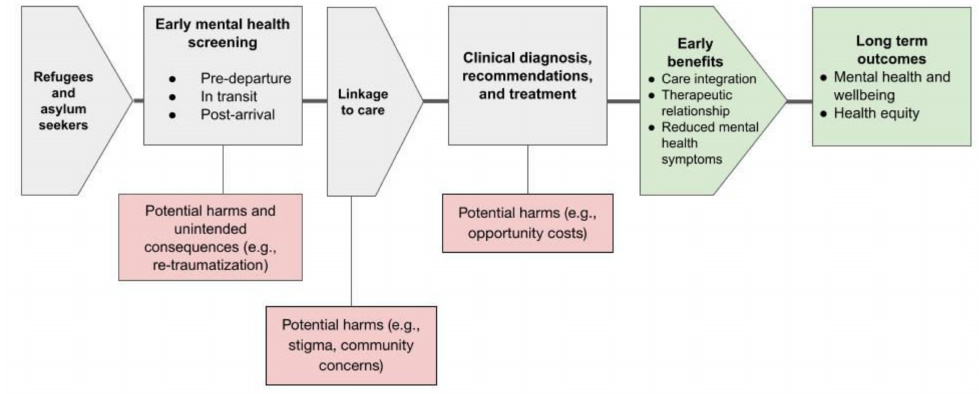
Figure 1. Logic model of mental health screening along the resettlement